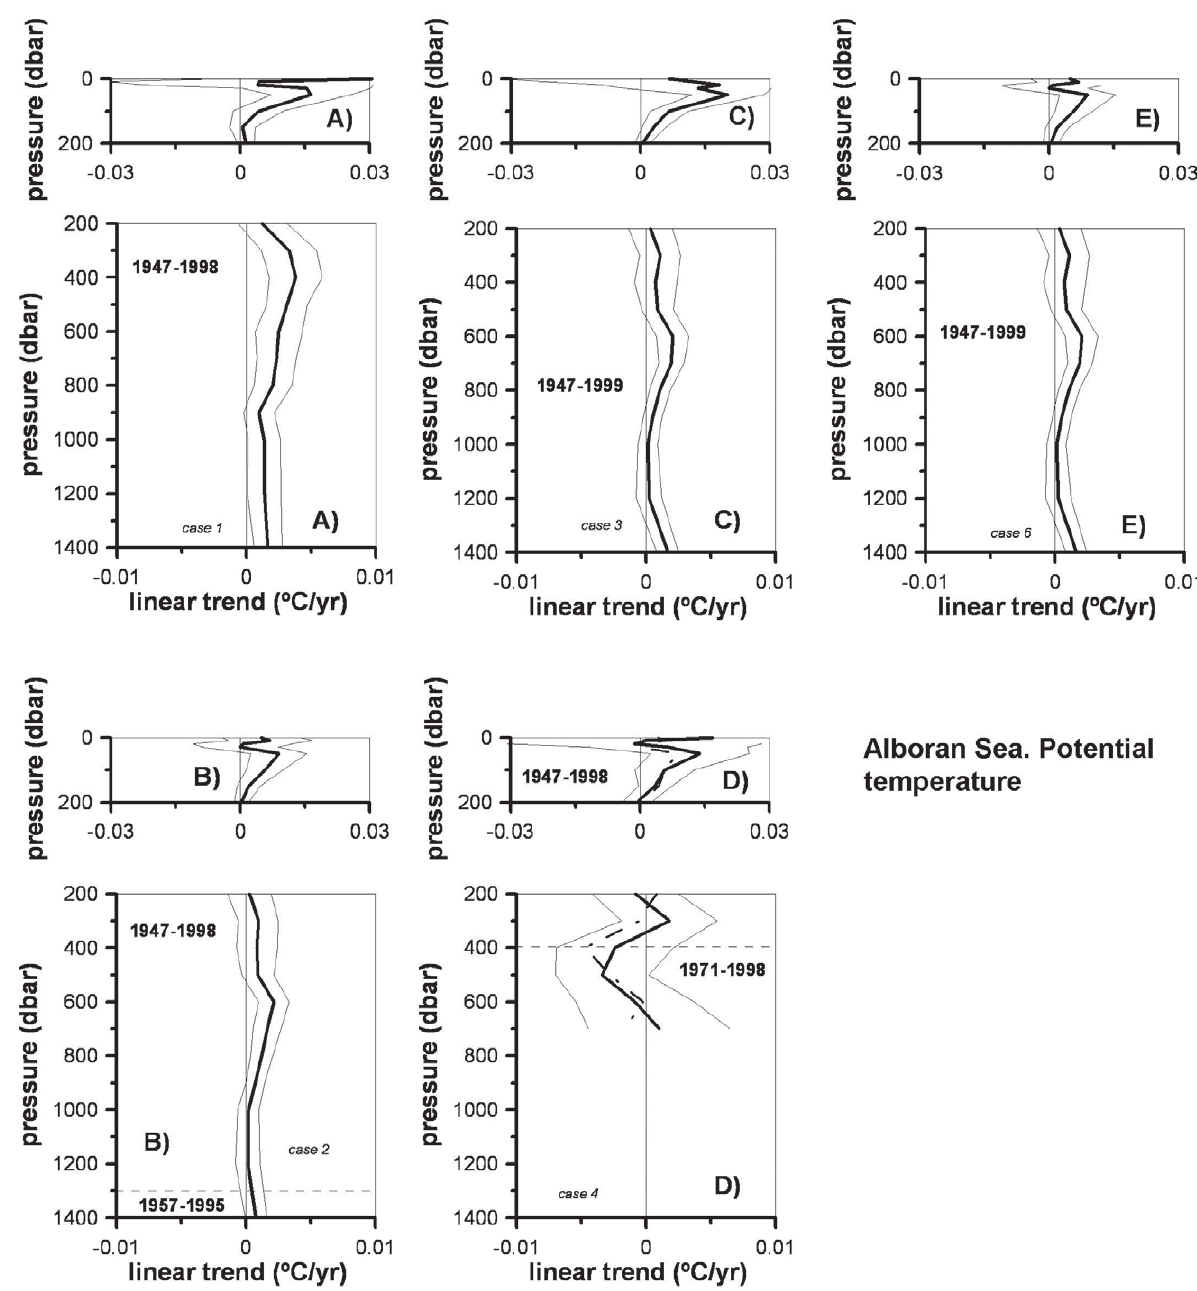
Fig . 6. – Potential temperature trends for the alboran sea as a function of pressure using different analysis methods. a for case 1 (see the text), b for case 2, c for case 3, D for case 4 and e for case 6. in all the figures the thick black line is the linear trend and the thin lines the 95% confidence intervals. in Figure 6D we have included case 6 (dash-dotted line) applied to the same period of time covered by case 4. Depending on the case, time series for different pressure levels have different extensions. The period analysed for the trend estimation is inserted in the plots. a dashed line indicates when there is an abrupt change in the length of the time